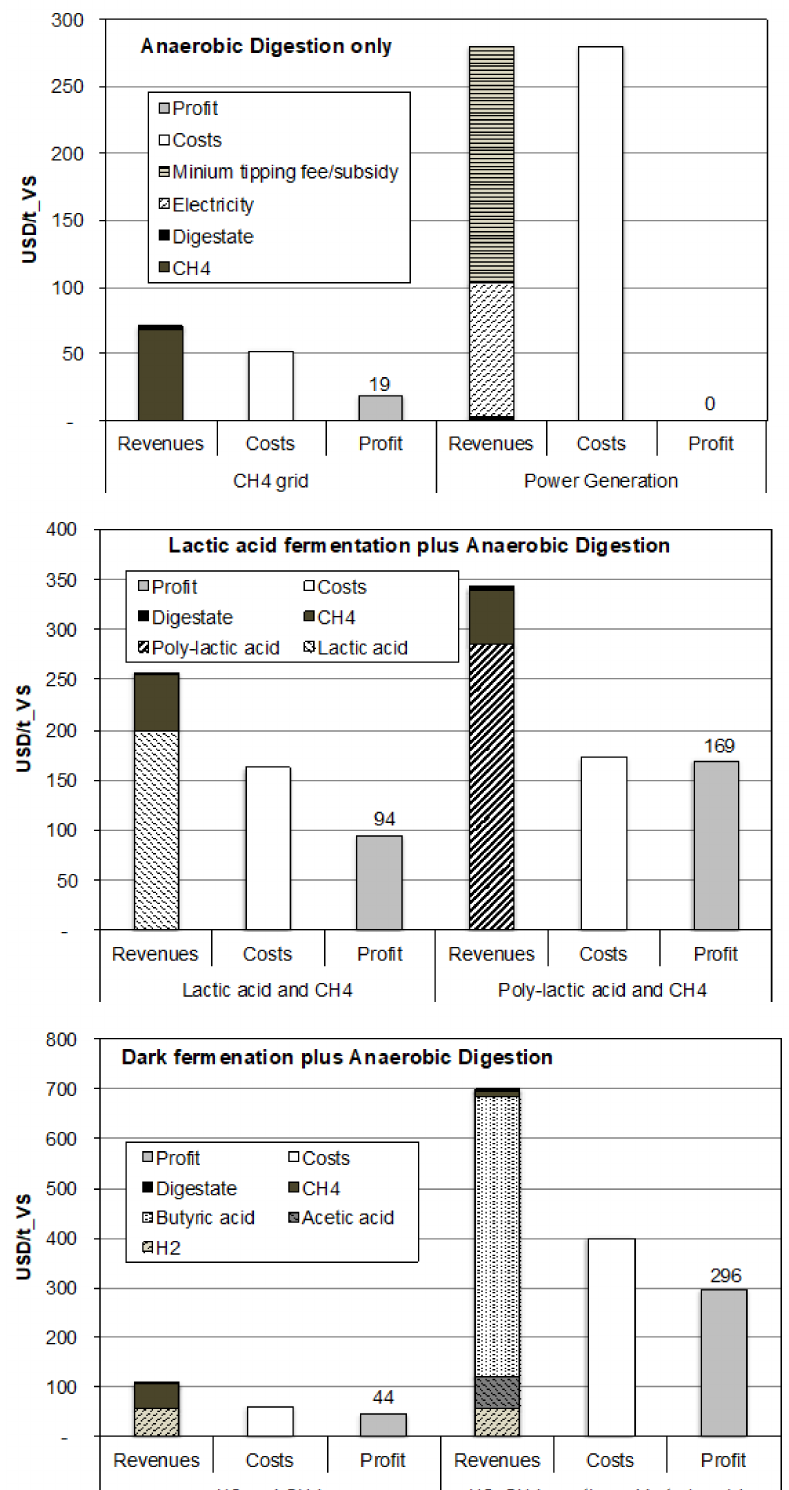
Figure 3. Economic assessment results for the different assessed